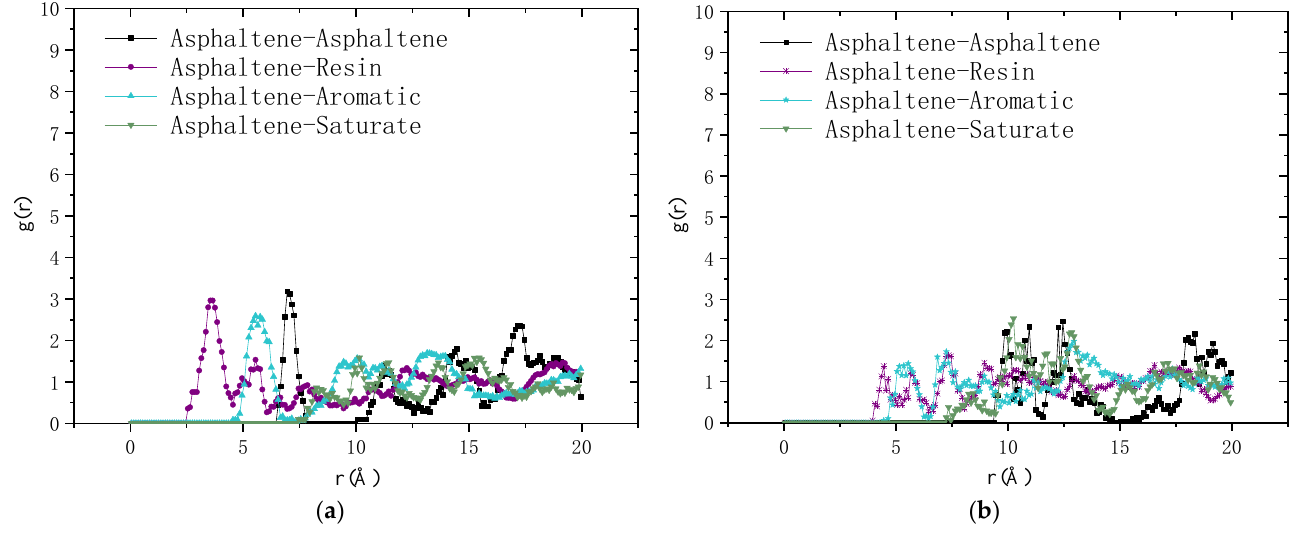
Figure 6. Radial distribution function for the pairs of asphaltene with the four components of asphalt binder: ( a ) neat asphalt binder; ( b ) aged asphalt binder.